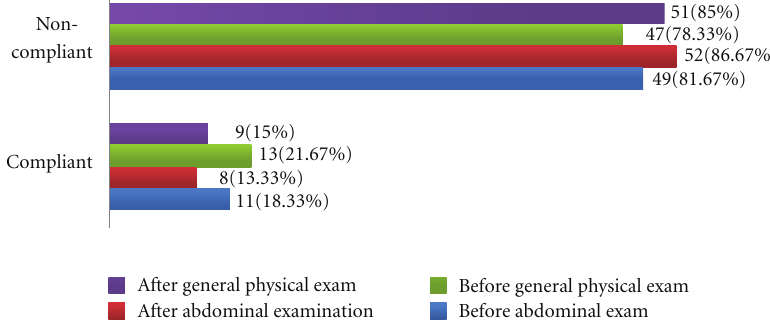
Figure 2: Compliance to hand hygiene among medical